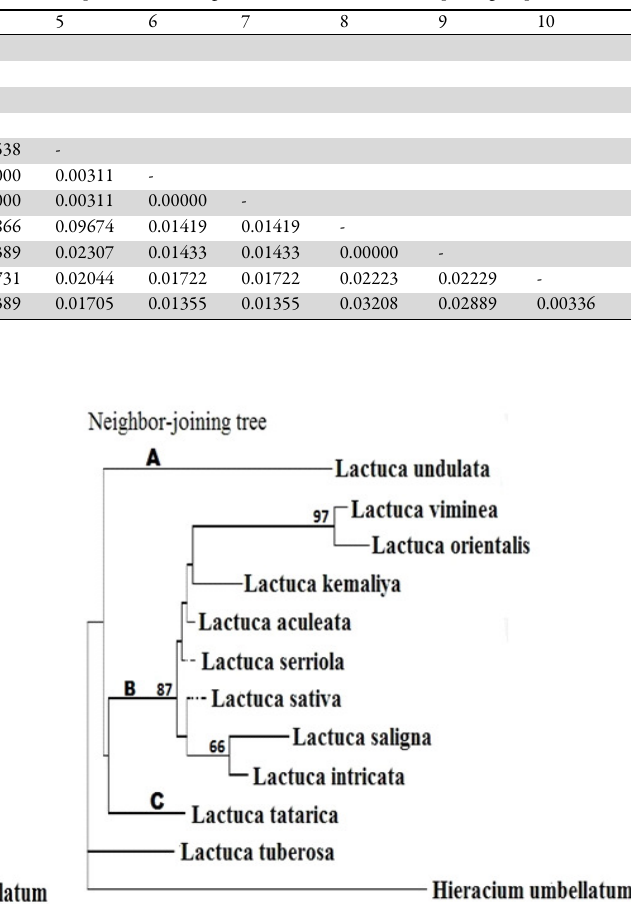
Fig. 2. The Neighbour Joining tree generated using trn L-F DNA sequences of genus Lactuca specimens and the related sequences retrieved from NCBI